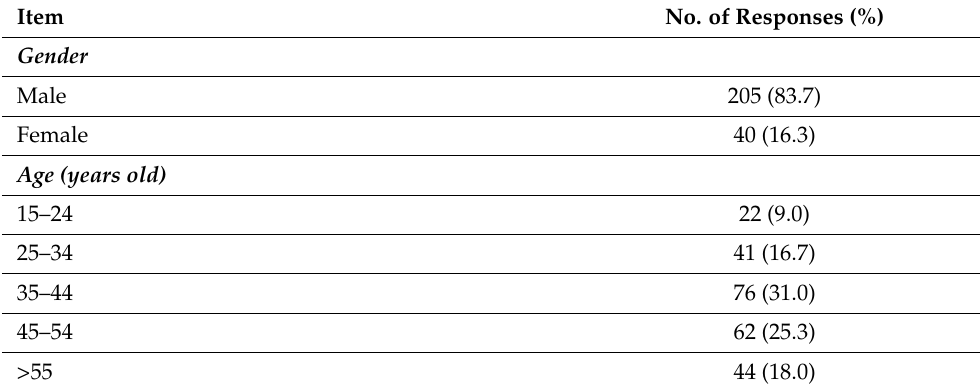
Table 1. Socio-demographic characteristics of interviewed active fish farmers in the five districts of the Rwenzori region of